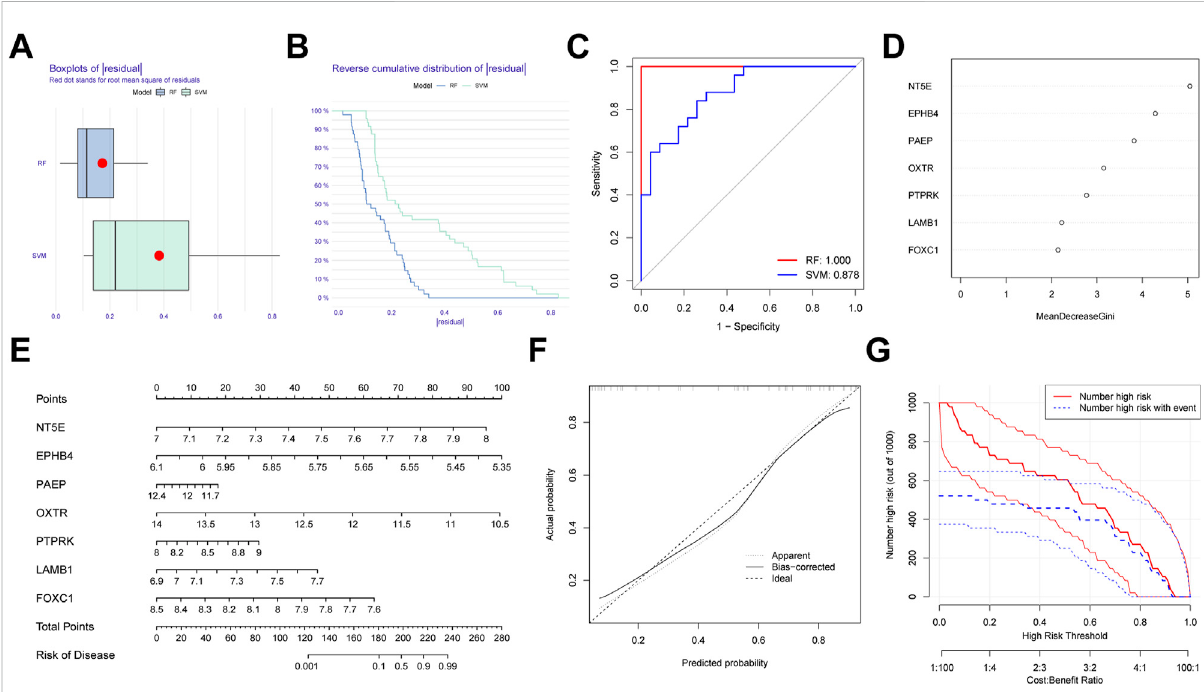
FIGURE 10 Establishment of the random forest (RF) Model for pre-eclampsia. (A) Boxplots of residual for RF and SVM model. (B) Reverse cumulative distribution RF and SVM model. (C) ROC curves indicated the accuracy of two models. (D) The importance of the seven hub genes based on the RF model. (E) ConstructionofanomogrambasedonRFmodel. (F) Calibrationcurverevealedthepredictiveabilityofthenomogram. (G) Clinicalimpact curve of the